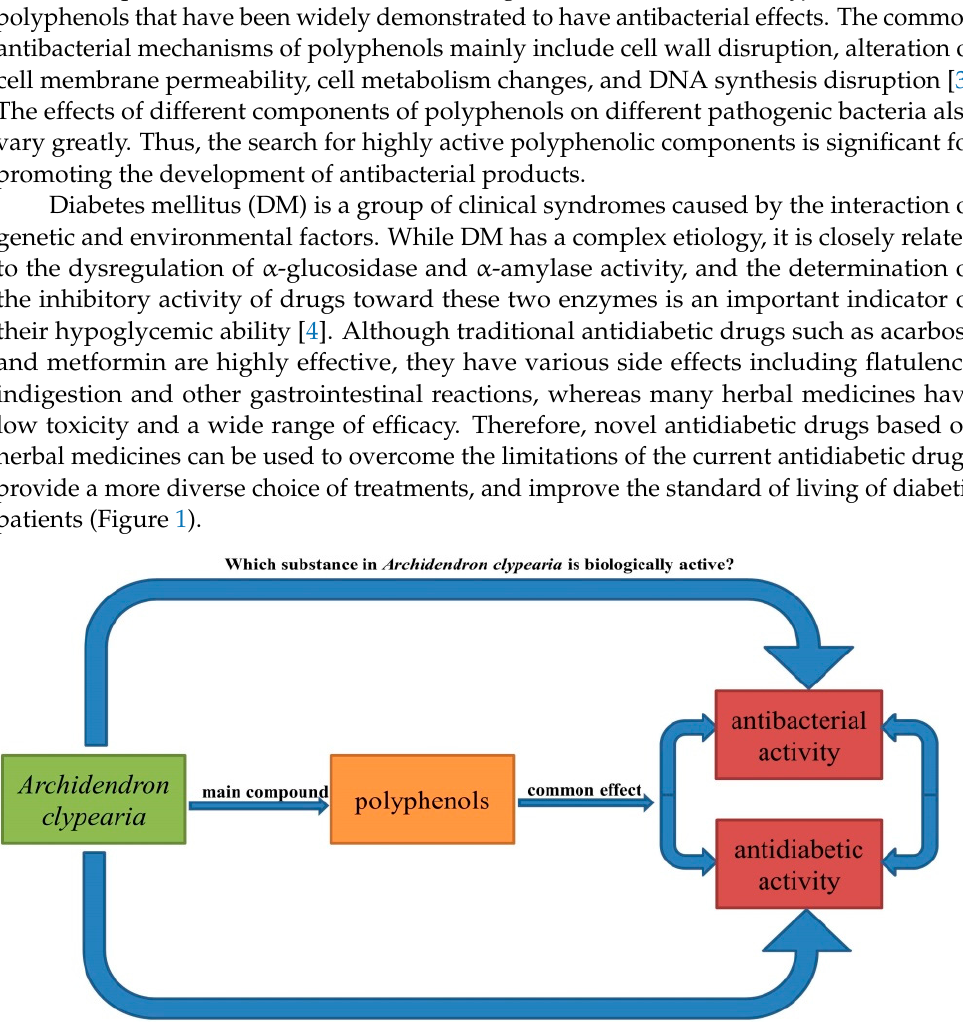
Figure 1. Correlation between A. clypearia and the selected targets.